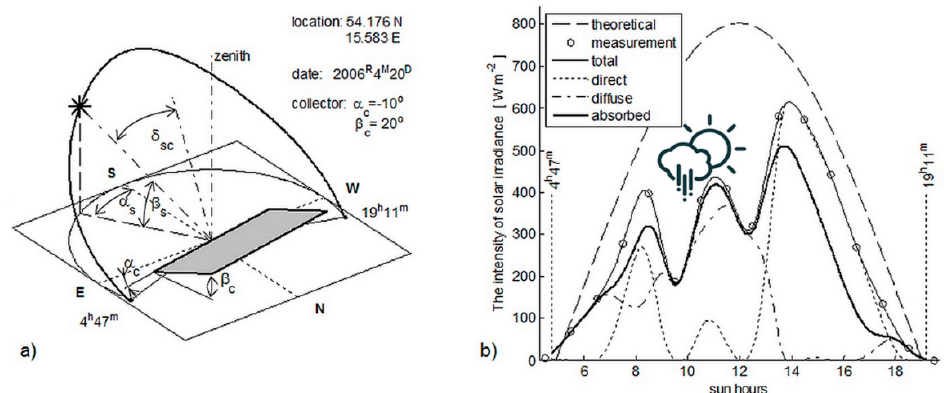
Figure 2. Daily fluctuations in solar position ( a ) and solar irradiance ( b ) on a selected day of the year for a selected orientation of the absorber surface.